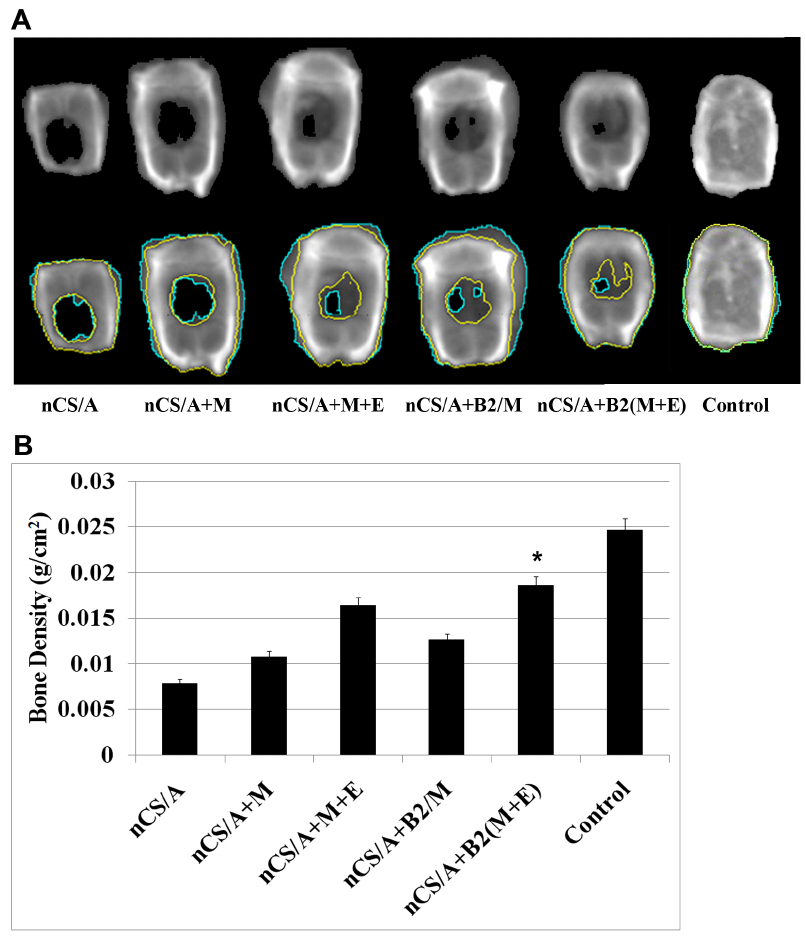
Figure 4. Bone mineral density analysis for bone growth in rat critical-sized calvarial defect model. (A) Images of calvarial bone obtained using LUNAR PIXImus system, 5 weeks after surgery. Upper row: general x-ray view. Lower row: x-ray with bone regeneration areas outlined in different colors. The black area circled with green lines in the implanted region is the low density area (fibrous tissue). The dark gray area between the green line and the yellow lines in the implanted region is the bone area with BMD that is lower than normal BMD. The area between the two yellow lines is considered the normal BMD area; bone density in this area is close to the BMD of normal bone tissue. (B) Quantitative analysis of bone density from A. The average BMD of normal intact bone is 0.0245 g/cm 2 . * p , 0.05: nCS/A + B2/(M + E) vs. each of the other five groups.